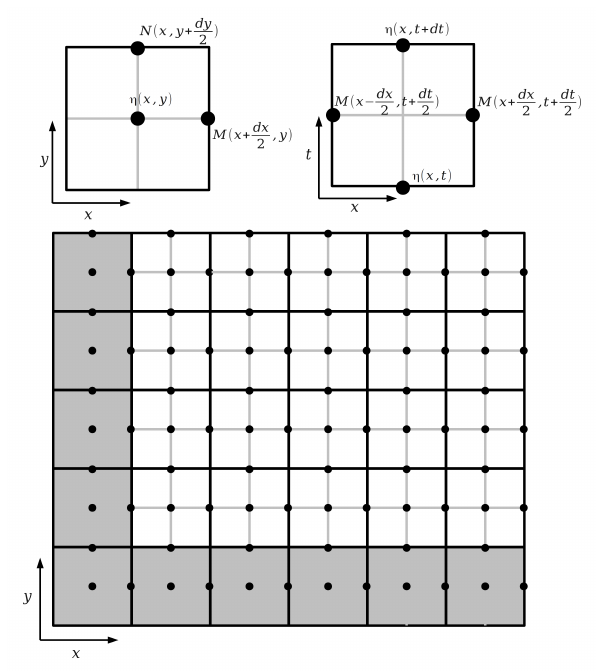
Fig. 2. Sketch of the staggered grid technique. Upper panel: (left) definition of the discretised variables on a space cell and (right) on the time axis but restricted to sea surface elevation η and the flux in the x direction M . Elevation η is computed in the centre of the cell, while fluxes M and N are shifted by a half spatial step along their respective directions. Lower panel: sample of a grid with grey cells on the bottom and on the left side of the grid. These are ghost cells that are outside the computational domain where only the dis- charge flux component on the side in common with white cells is